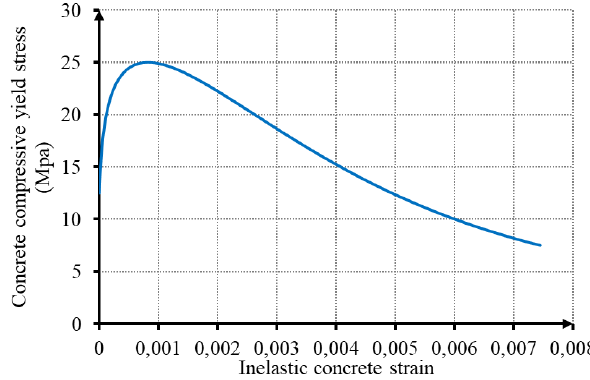
Figure 31: The relation between concrete compressive stress